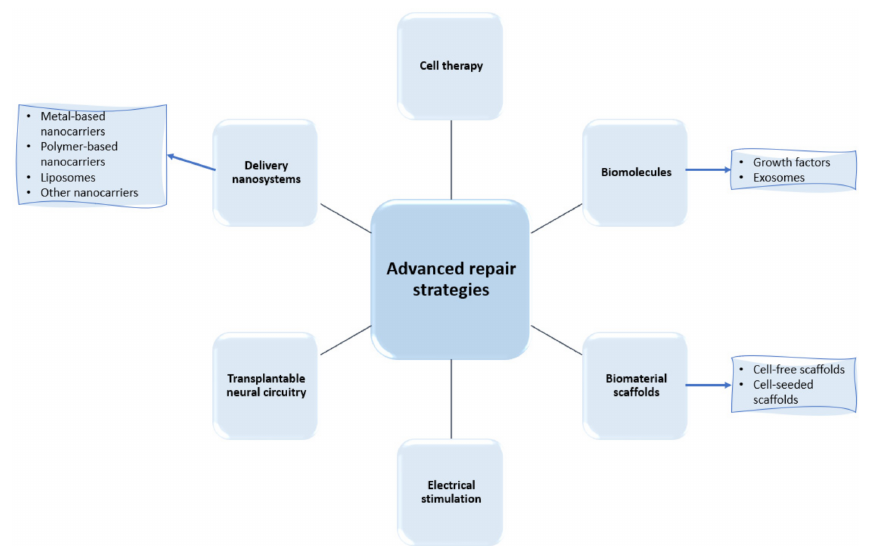
Figure 3. Examples of recently researched spinal cord regeneration